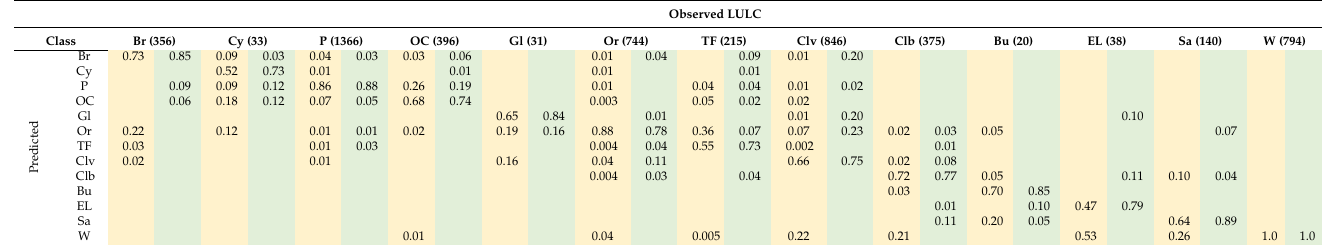
* Yellow and green columns present the RF and SVM classifiers, respectively. The number in parenthesis comes after LULC class name indicating the number of validation pixels for the corresponding